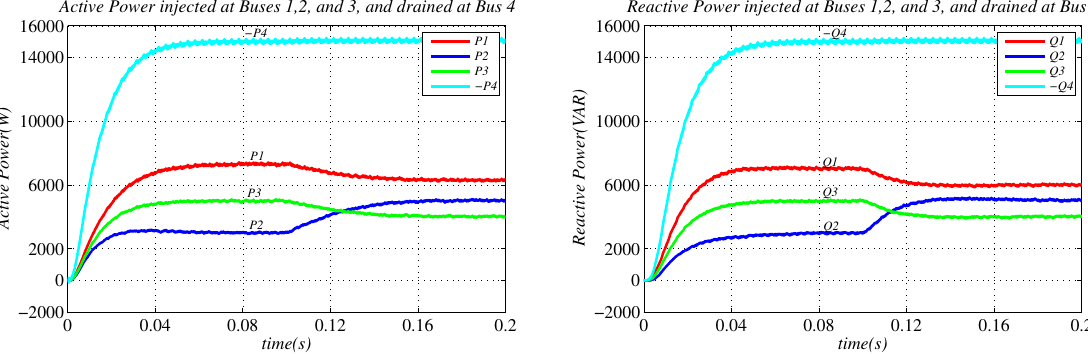
Figure 8. Active power and reactive power injected at Buses 1, 2, and 3, and drained at Bus 4.